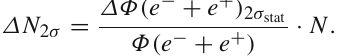
numbers of events for 2 σ deviations from statistical fluctuations. Thus, we should require | Δ N | ≤ | Δ N 2 σ